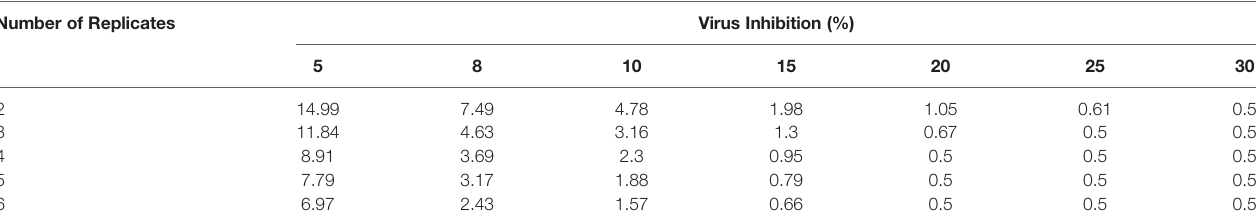
TABLE 1 | At 90% statistical power, the minimum percentage of p24+ cells (in HIV-CD4 T cell cultures) needed to observe a threshold virus inhibition of 5-30% for 2-6 replicates. Number of Replicates Virus Inhibition